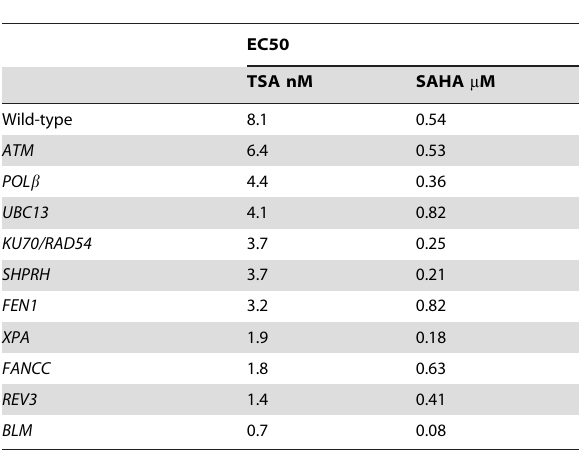
Table 2. EC50 values for isogenic chicken DT40 B lymphocyte cell lines following 48 hour treatment with TSA and